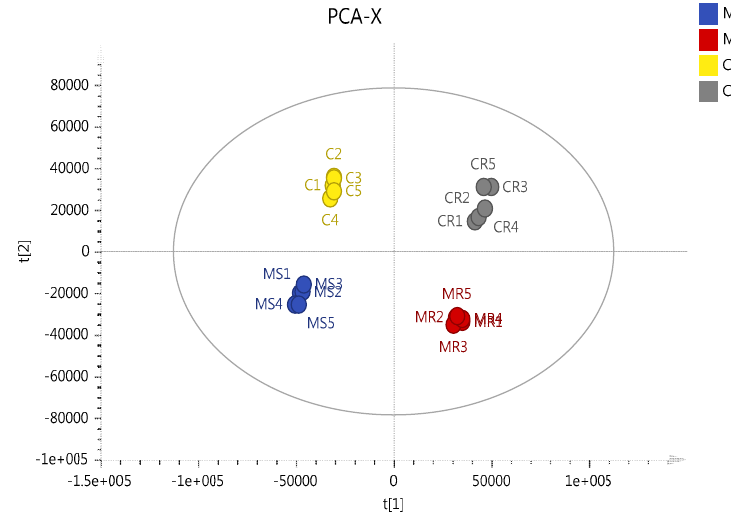
Figure 5. Multivariate data analysis of the ovarian cancer cells A2780 and A2780CR treated with melittin. PCA scores plot generated from PCA using LC-MS normalised data of treated cells and controls. MS circles: A2780-treated cells; C circles: untreated A2780 cells; MR circles: A2780CR -treated cells; CR circles: untreated A2780CR.